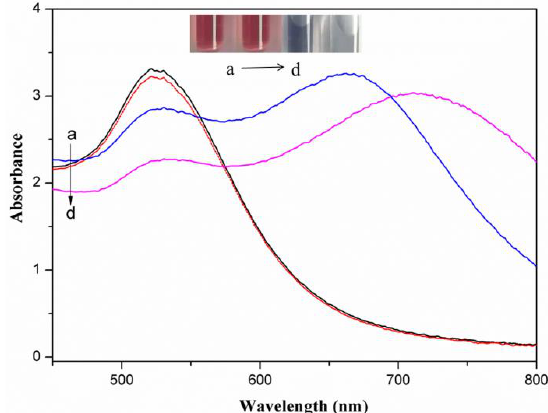
Figure 1. (a → d) Surface plasma resonance absorbance spectra for gold nanoparticles (AuNPs), AuNPs with 2.0 mg/L metsulfuron-methyl, AuNPs with 2.0 mg/L metsulfuron-methyl and 2.0 mg/L melamine, and AuNPs with 2.0 mg/L melamine, respectively (acetate buffer solution: 10 mM, pH 3.5, 0.2 mL). Insert: picture of AuNPs solutions.